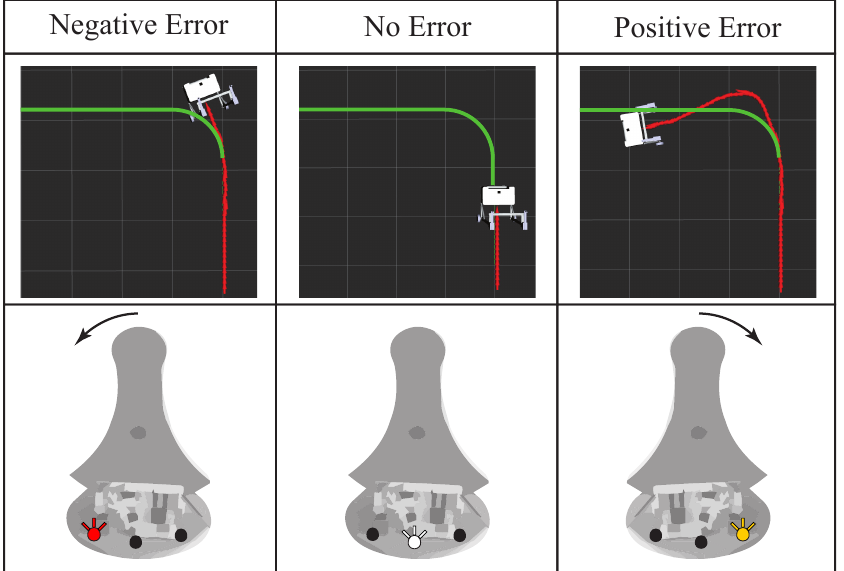
Figure 4. Illustration of the feedback strategy on the joystick. Three LEDs placed on the base of the device indicate the existence or absence of a path following error. The arrows indicate how to move the joystick to correct the error. The desired path is shown in green. The achieved path is shown in